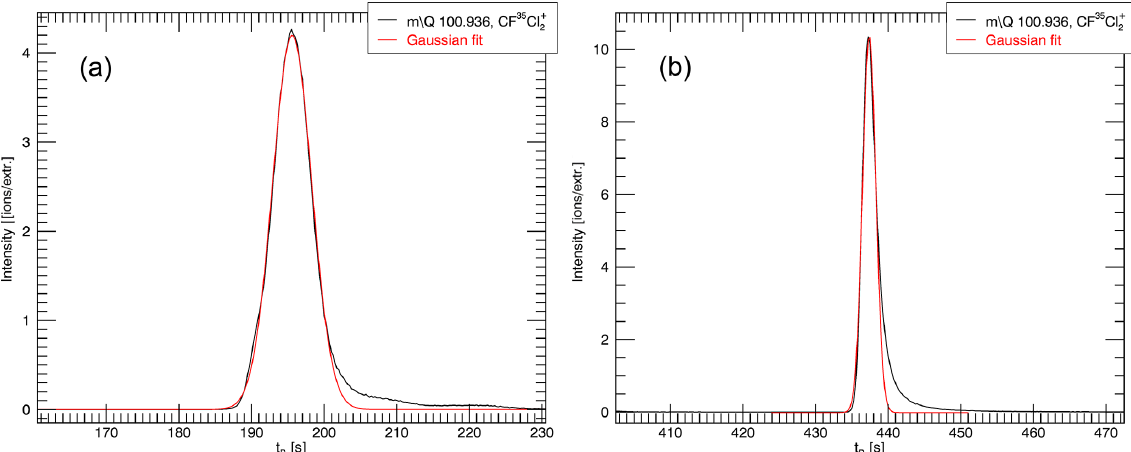
Figure 5. Comparison of chromatographic peak shapes of the CF 35 Cl + fragment ion signal of CFC-11 (CFCl 3 ) from an injection of 1L 2 preconcentrated ambient air onto the GC column kept isothermal at 150 ◦ C (a) and onto the GC column kept at 45 ◦ C and ramped to 200 ◦ C subsequently ( b ; see Sect. 3.1). X axis: retention time t R in seconds; t R interval shown is 70s in both plots. Y axis: signal intensity expressed as ions per extraction (see Fig. 4). The red curve shows a Gaussian fit for comparison of actual peak shape and a peak shape that is considered ideal. FWHM of fit: (a) 6.3s (0.10min) and (b) 2.0s (0.03min). Adsorptive material: Unibeads